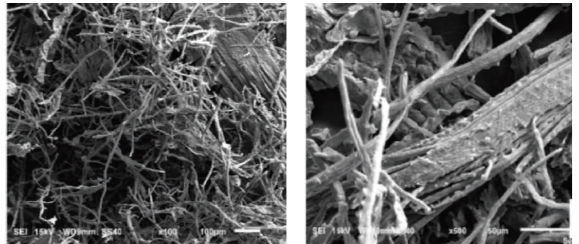
Figure 2: Cellulose images obtained from rice husks and taken under scanning electron microscopy (SEM), coated with colloidal gold, are shown as follows: on the left, treatment with 10 grain mech, amplifed × 100 (100 μ m), on the right, shows with grain 30 mech amplifed × 500 (50 μ m). (source: author